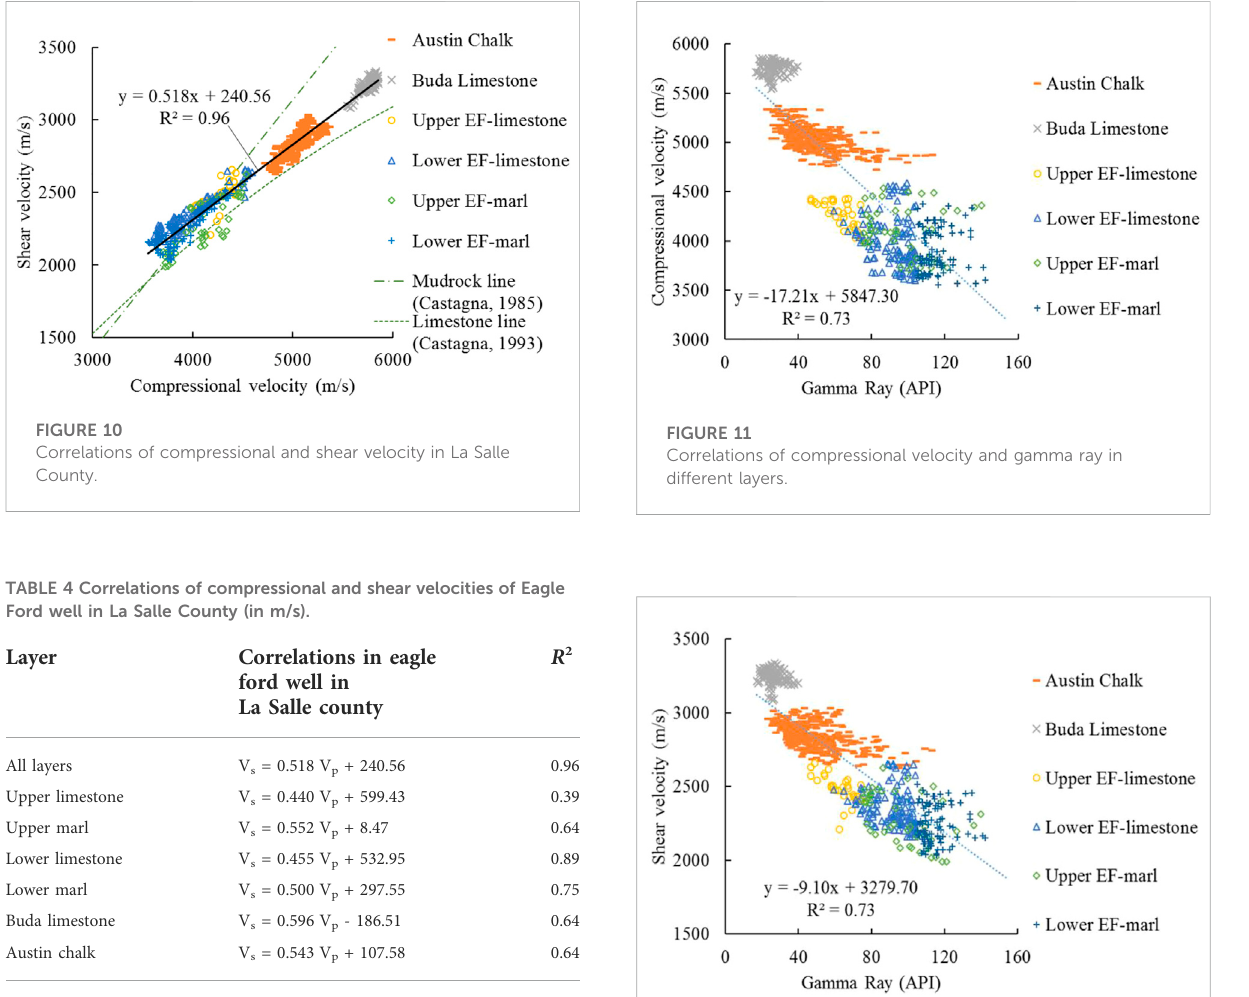
FIGURE 12 Correlations of shear velocity and gamma ray in different